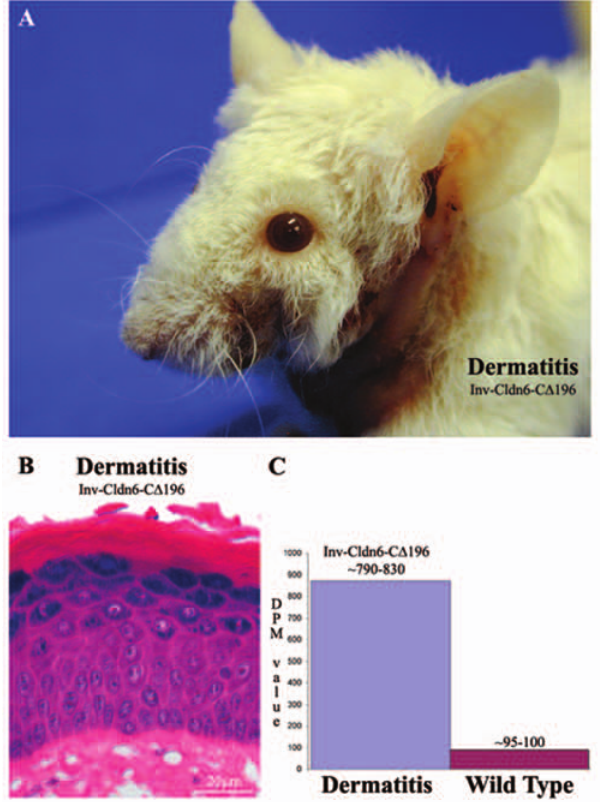
Figure 7. Aging-associated barrier dysfunction. Upon gross observation, obvious signs of dermatitis were evident in aging Inv- Cldn6-C D 196 transgenic mice, especially in areas subjected to repetitive mechanical stress such as the neck and behind the ears ( A ). Histological evaluation revealed a significantly thickened epidermis with an increased number of spinous/suprabasal cell layers and cellular disorganization; the upper differentiation layers were also abnormal, with parakeratosis, the prevalent appearance of nuclei, an improperly packed granular layer and a thicker stratum corneum ( B ). TEWL measurements across the dermatitis-affected transgenic skin confirmed an approximately 8-fold increase in water loss and a barrier deficient phenotype ( C